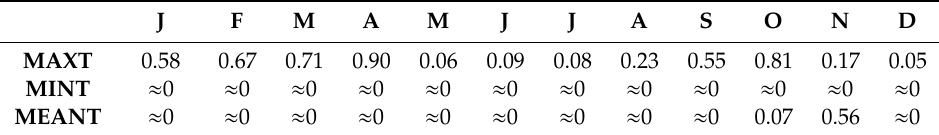
Table 1. T -test of the di ff erence of means (t-values) between the urban and suburban stations for daily maximum ambient air temperature (MAXT), minimum ambient air temperature (MINT), and mean temperature (MEANT). The initials in the horizontal column indicate months of the year. J F M A M